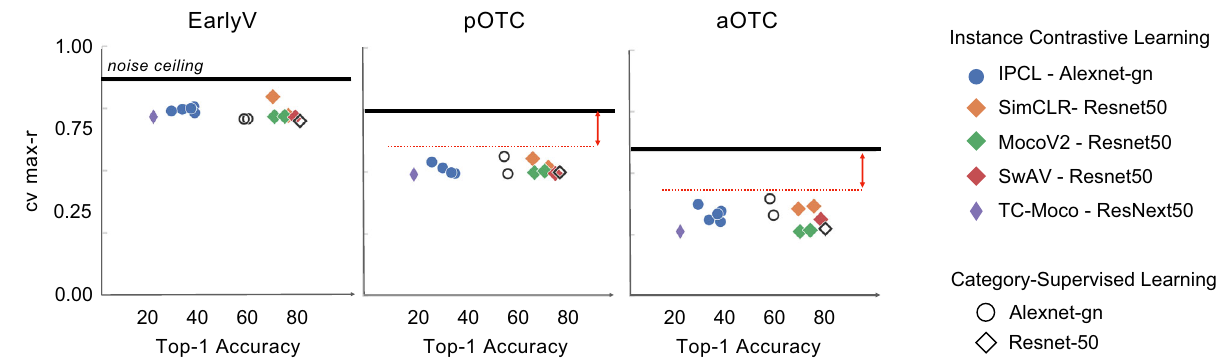
Fig. 4 Relationship between object classi fi cation accuracy and brain predictivity. The x- axis plots top-1 classi fi cation accuracy, and the y-axis plots the cross-validated max correlation with the Inanimate Object dataset, in each of the three brain sectors. Self-supervised contrastive learning models are shown with colored markers and category-supervised with open markers. Model architecture is indicated by marker shape. Red dashed lines and double- headed arrows draw attention to the gap between these model fi ts and the reliability ceiling of these brain data. Source data are provided as a Source Data fi